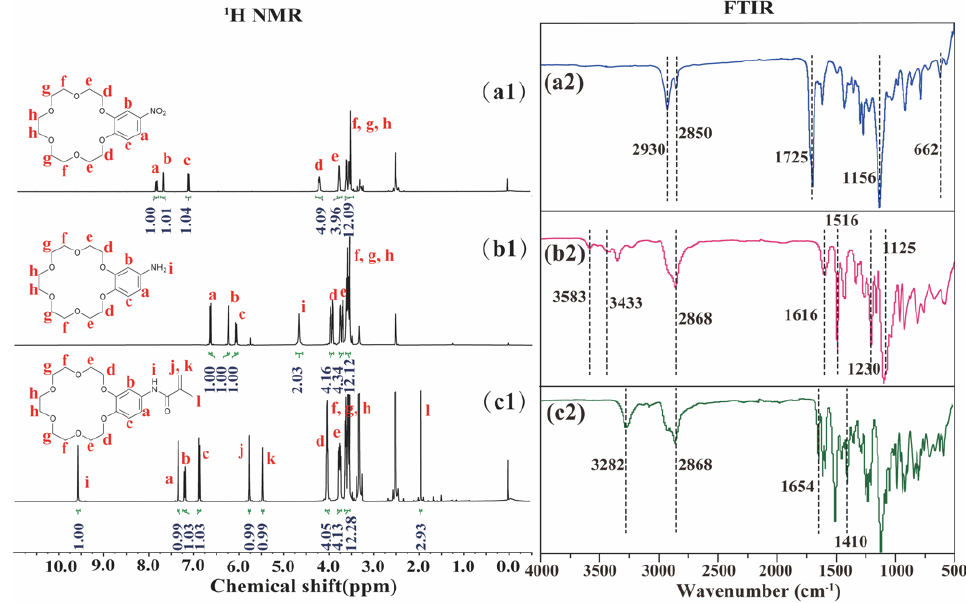
Figure 1. 1 H NMR and FTIR spectra of monomers: 4 − nitrobenzo − 18 − crown-6 ( a1 , a2 ); 4 − amino- benzo − 18 − crown − 6 ( b1 , b2 ) and B18C6Am ( c1 , c2